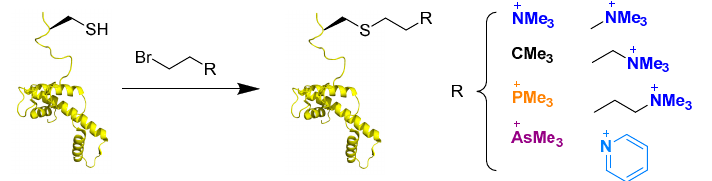
Figure 17. Analogues of Kme3 generated by Cys4 alkylation of histone H3 and recognized by the PHD3 reader domain of JARID1A. (Reprinted (adapted) with permission from Bioconjugate Chem. 2019, 30, 3, 952-958. Copyright 2020 ACS Publications.).